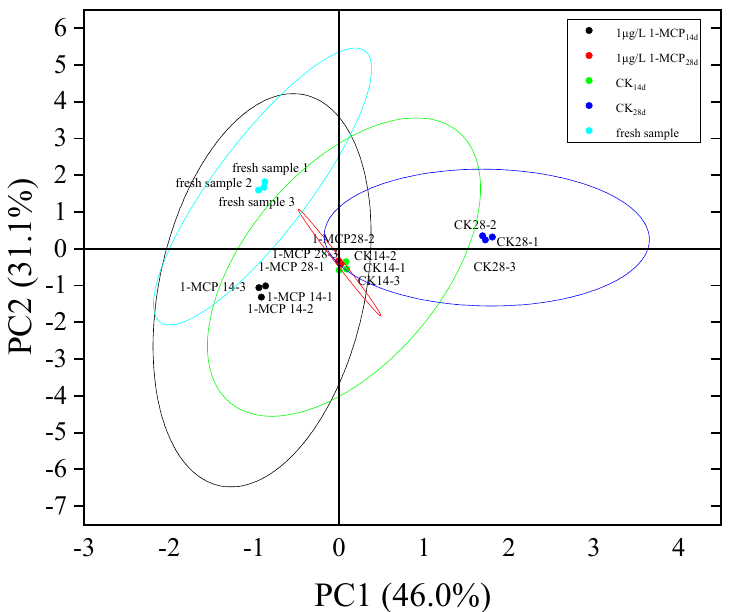
Figure 7. PCA analysis of storage quality and enzyme activity of root mustard at different storage times for control and 1.0 µL L − 1 1-MCP. Ellipse represent confidence intervals.